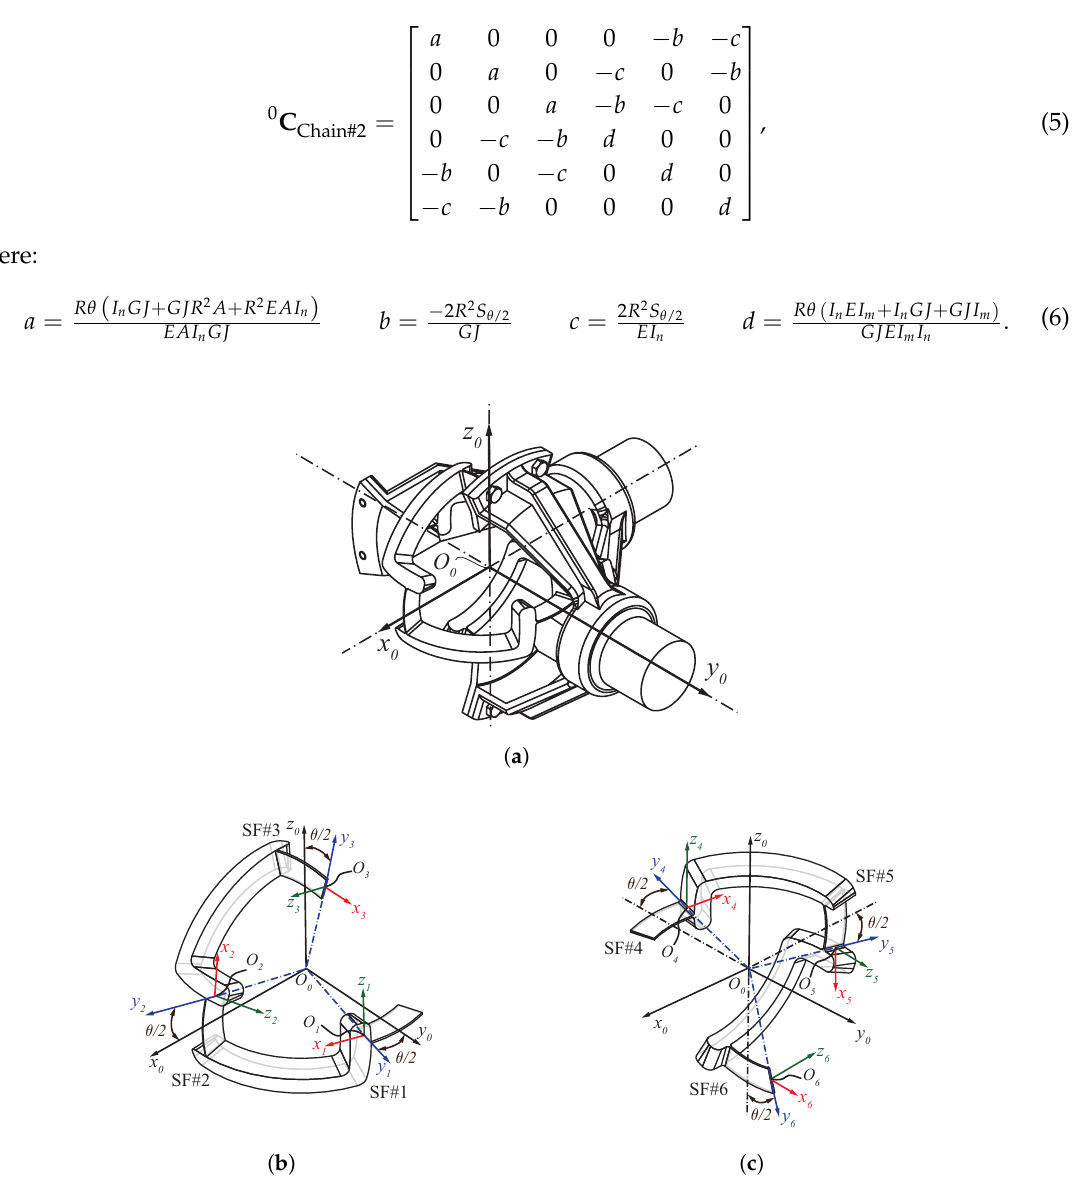
Figure 4. Compliant spherical joint ( a ) composed of two compliant serial chains, namely Chain#1 ( b ) and Chain#2 ( c